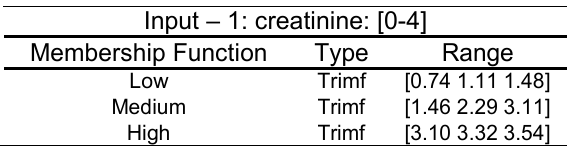
Table 3. Values obtained for the construction of membership functions of creatinine